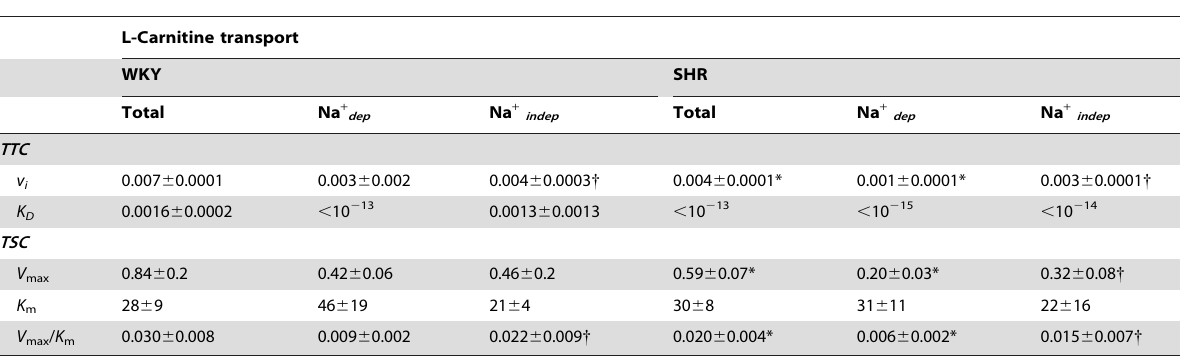
Table 1. Kinetic parameters for transport of L-carnitine in rat aortic endothelial